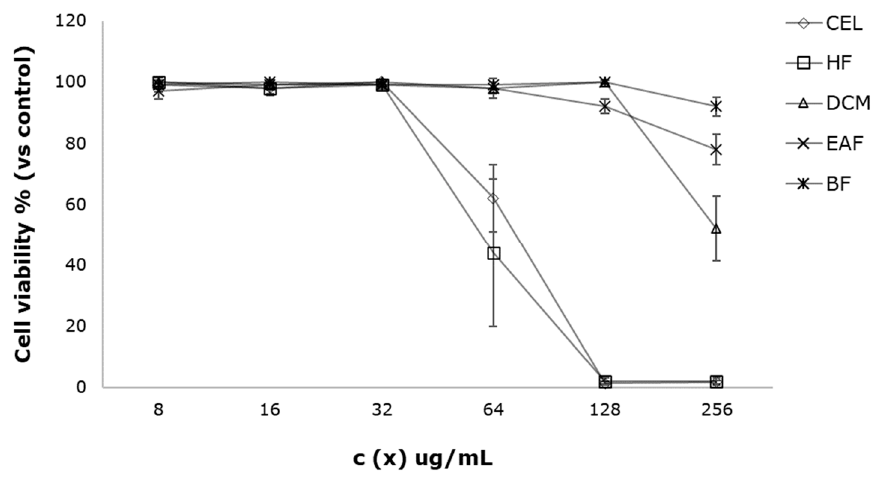
Figure 1. Effect of crude extract (CEL), n -hexane fraction (HF), dichloromethane fraction (DCM), ethyl acetate fraction (EAF) and n -butanol fraction (BF) on RAW 264.7 murine macrophage cell viability. The effect on the cell viability was determined by the resazurin assay. All values are expressed as the mean ± SD of three replicates. Tamoxifen was the reference control drug for cytotoxicity.